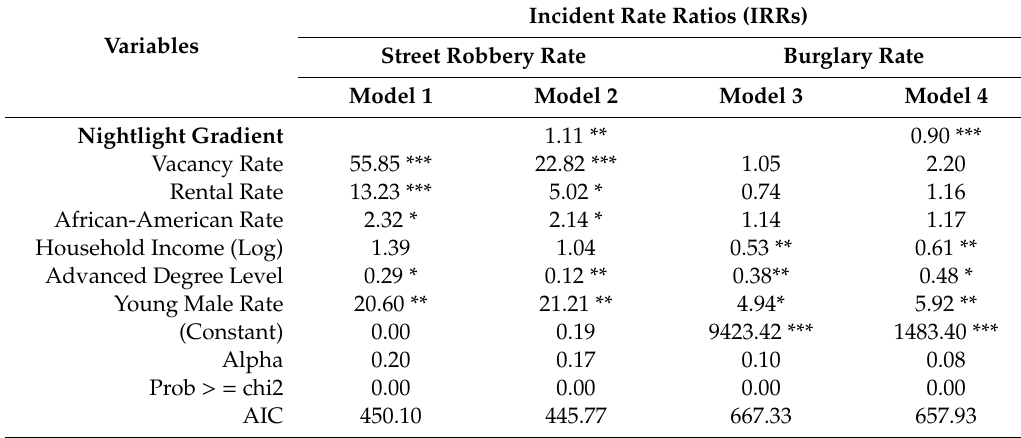
Table 5. Results of negative binomial regression models.